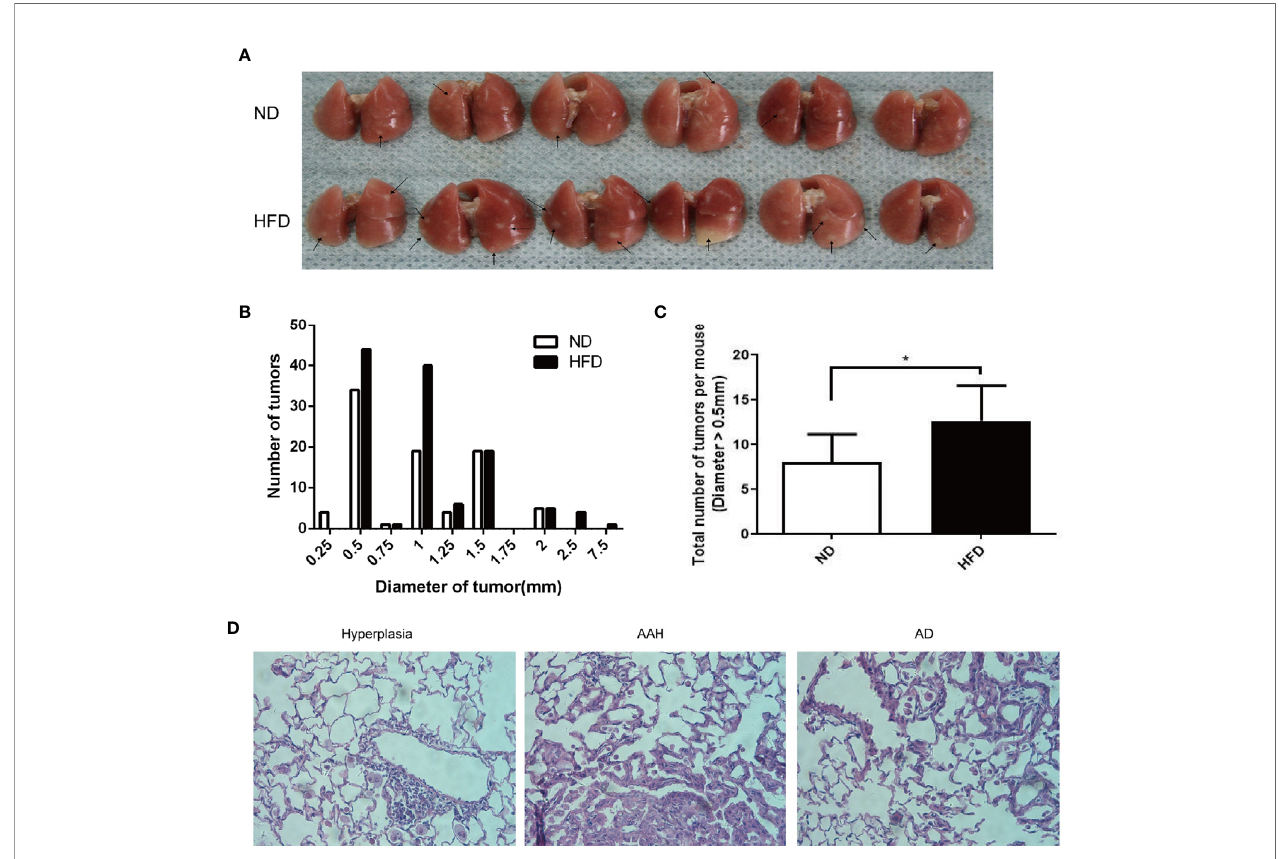
FIGURE 2 | Increased burdens of lung tumor in HFD-fed C57BL/6J mice compared to that in ND-fed mice. (A) Gross photo of surface lung nodules in urethane- administered and HFD-fed and ND-fed mice. Arrows point to selective visible lung tumors. (B) Distribution of nodule diameters between two diet groups (n = 6 mice/ group). (C) Numbers of nodule diameter larger than 0.5 mm between the two diet groups (n = 6 mice/group). *P < 0.05. (D) Representative H&E staining of lung sections in urethane-administered mice, showing epithelial cell hyperplasia (Left), atypical adenomatous hyperplasia (AAH, Middle) and papillary and solid adenoma (AD,